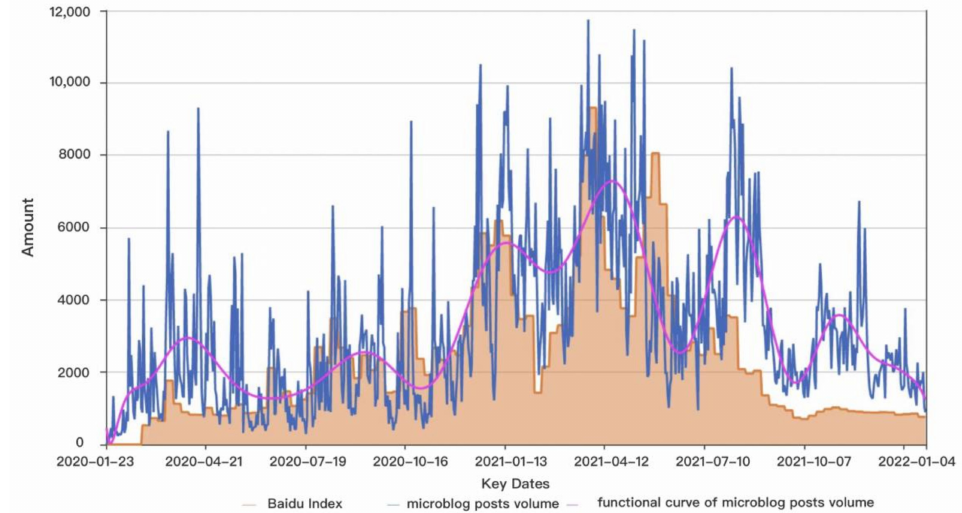
Figure 5. The number of Sina Weibo and Baidu index over the entire study